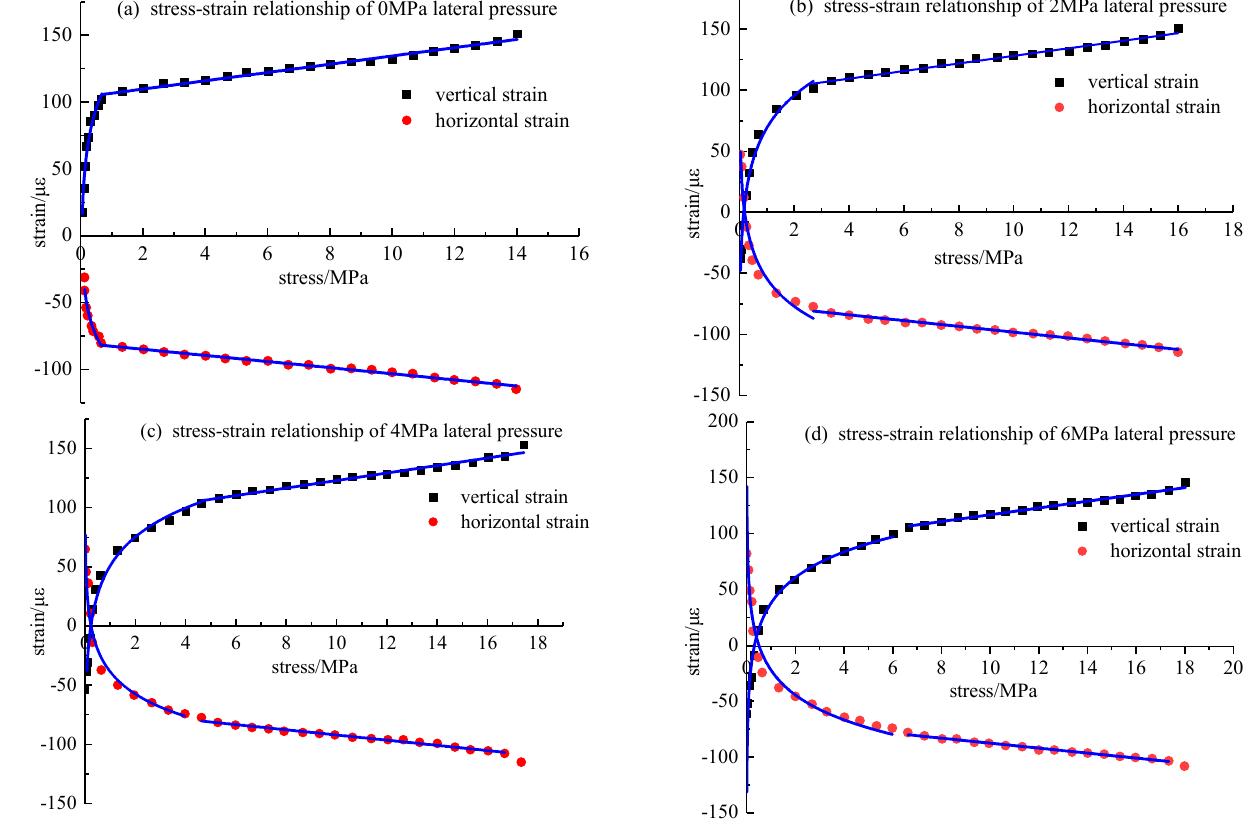
Figure 10. Vertical and horizontal stress–strain relationship under different lateral pressure conditions.